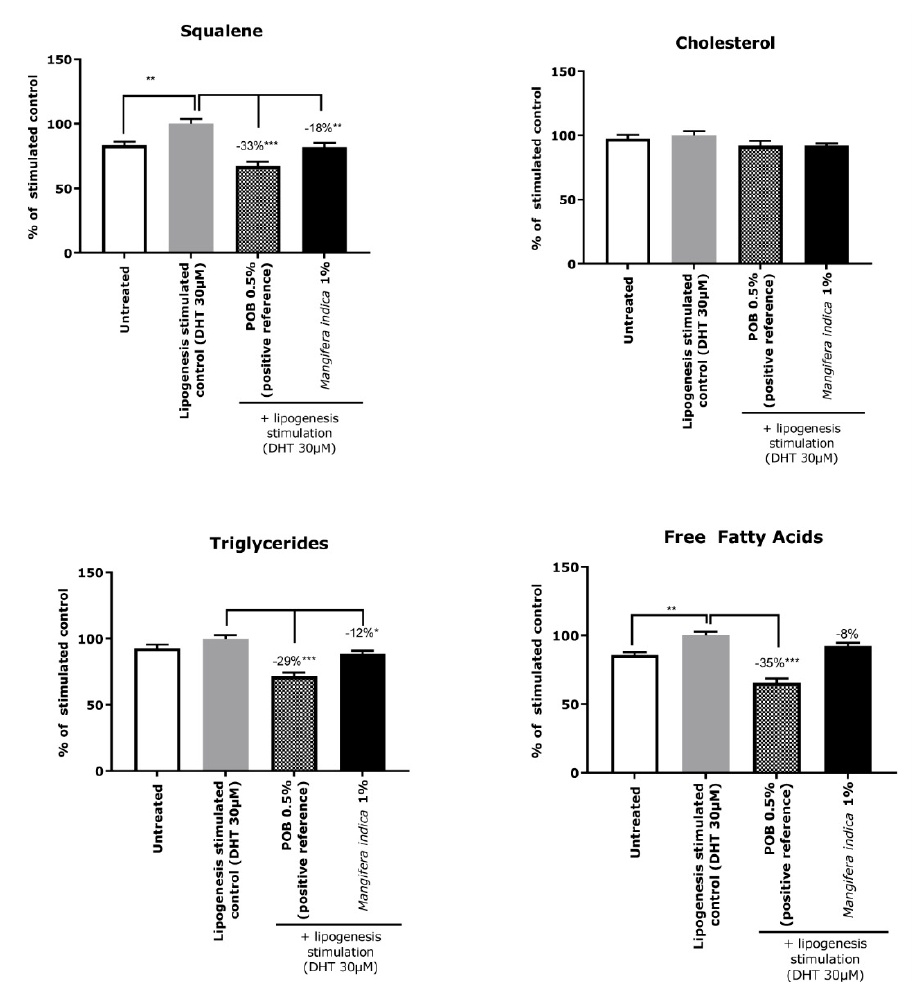
Figure 4. Lipids extracted from sebaceous glands and quantified by GC/MS or LC/MS. The results are expressed in percent of the stimulated control (Untreated + DHT 30 µ M). ANOVA followed by Dunnett’s multiple comparisons test was used to determine the significance of the data with * p < 0.05, ** p < 0.01 and *** p < 0.001.